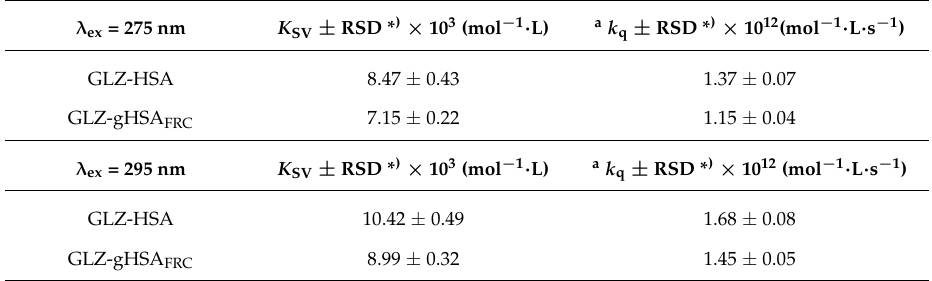
Table 2. Stern-Volmer constants 𝐾 (cid:3020)(cid:3023) (mol − 1 ∙ L) and biomolecular quenching rate constants 𝑘 (cid:2927)